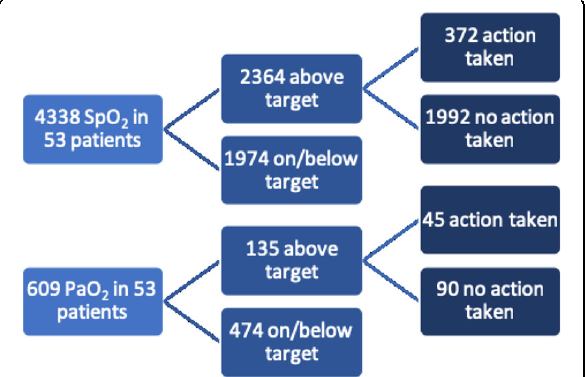
Fig. 1 (abstract 00049). A proportion of hyperoxic SpO 2 and PaO 2 in 53 consecutive ICCU patients resulted in a reduction in FIO